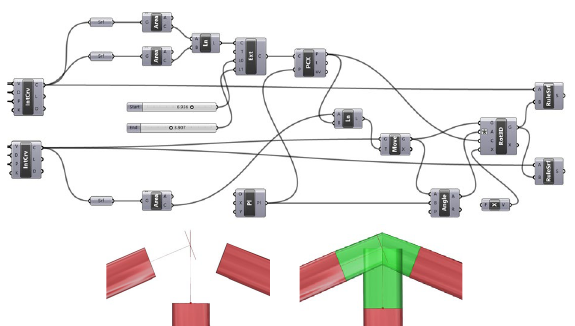
Figure 7: Part of the algorithm for the ridge completion After completing automatic modeling of all joints, wood girders